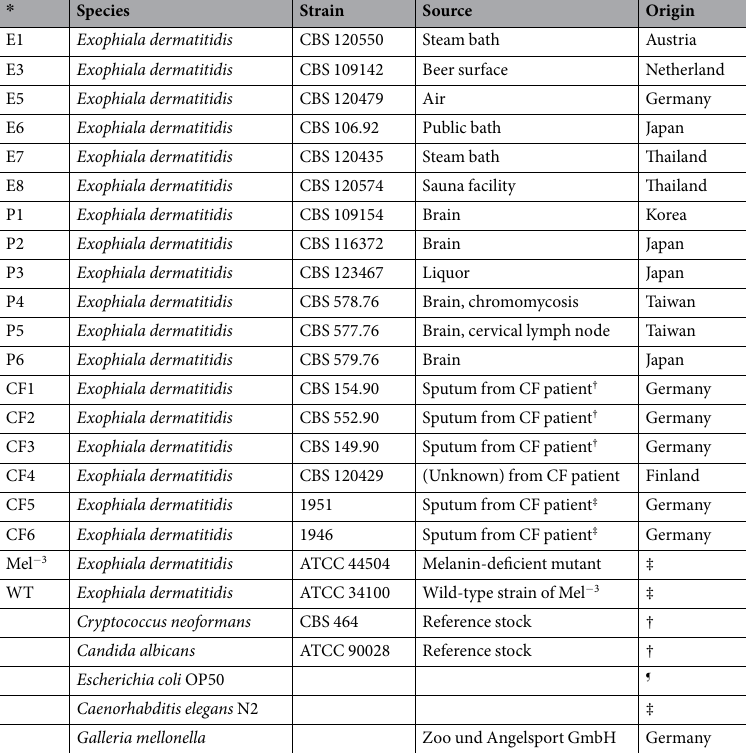
Table 2. Source and origin of included Exophiala dermatitidis strains. * Identification nomenclature used in this study: E, environmental strains; P, strains from Asian patients; CF, strains isolated from patients with